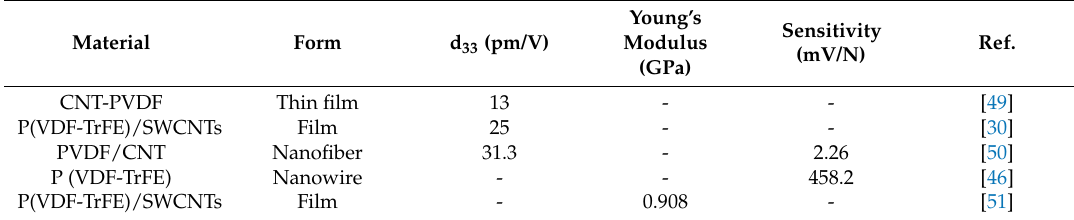
Figure 5. The piezoelectric pressure sensor used for monitoring vital signs and muscle motion. The voltage output of detected ( a ) pulse rate, ( b ) breathing, ( c ) swallowing, and ( d ) chewing. The inset photographs represent the position where the sensor was mounted. Table 1. Summary of the characteristics of the PVDF-based membranes in this study and other recently reported